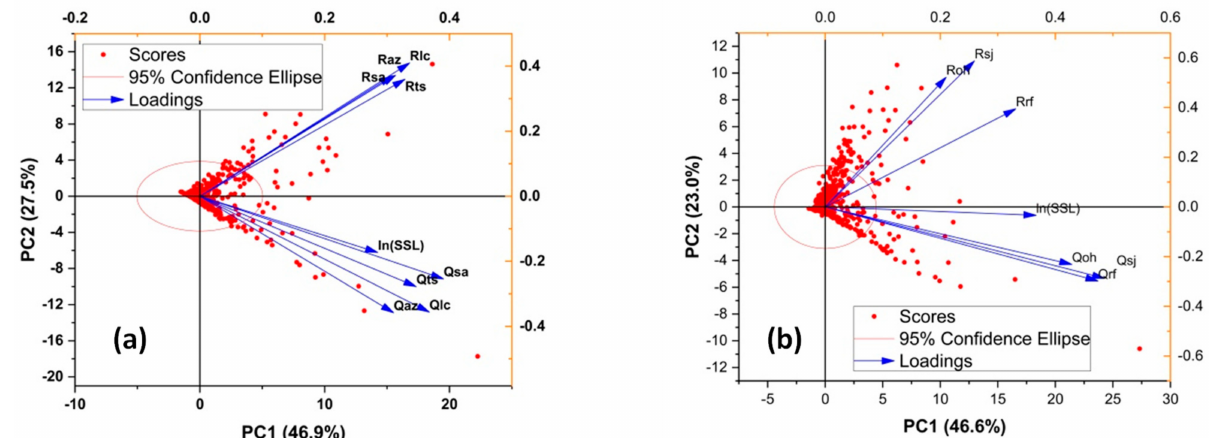
Figure 2. Principal component analysis (PCA). ( a ): PCA of data recorded at Bouregreg basin; ln(SSL) is the Napierian logarithm of the suspended solid; Ras and Qas are rainfall and discharge at Aguibat Ziar station; Rlc and Qlc are rainfall and discharge at Lala Chafia station; Rts and Qts are the rainfall and discharge at Tsalat station; Rsa and Qsa are the rainfall and discharge at Sidi Amar station. ( b ): PCA of dataset recorded at Grou